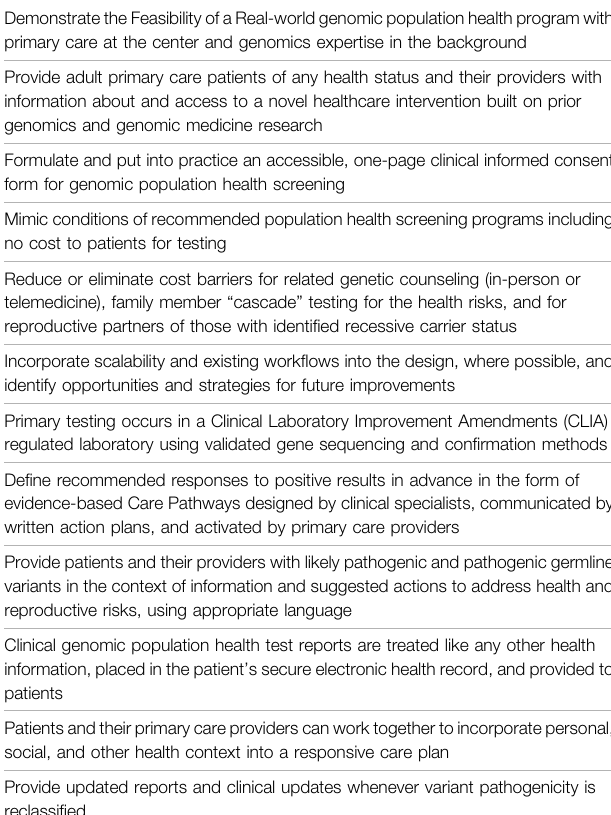
TABLE 1 | Key goals of the genomic population health pilot implementation